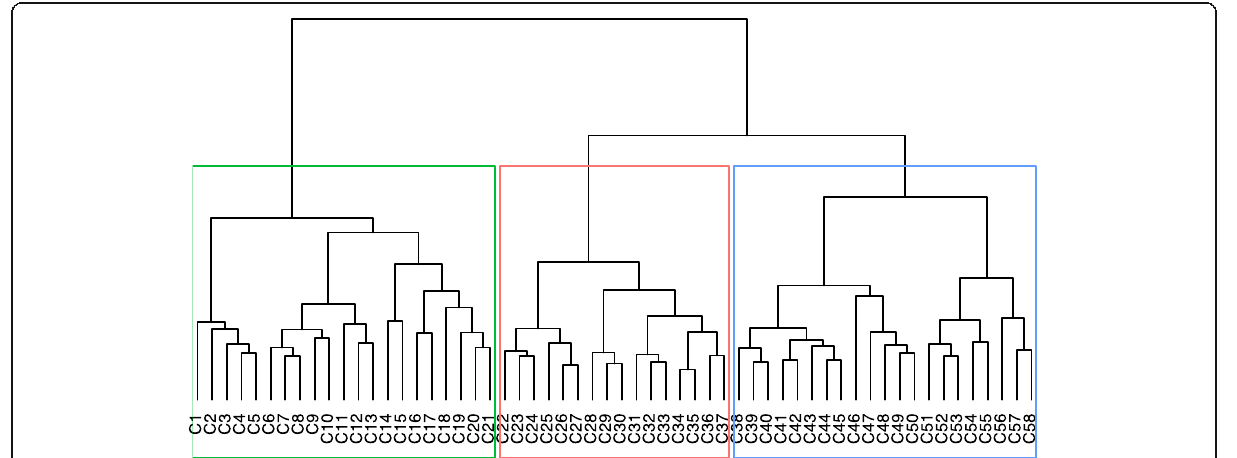
Fig. 1 Dendrogram showing the hierarchical structure of the observed chemistry lab